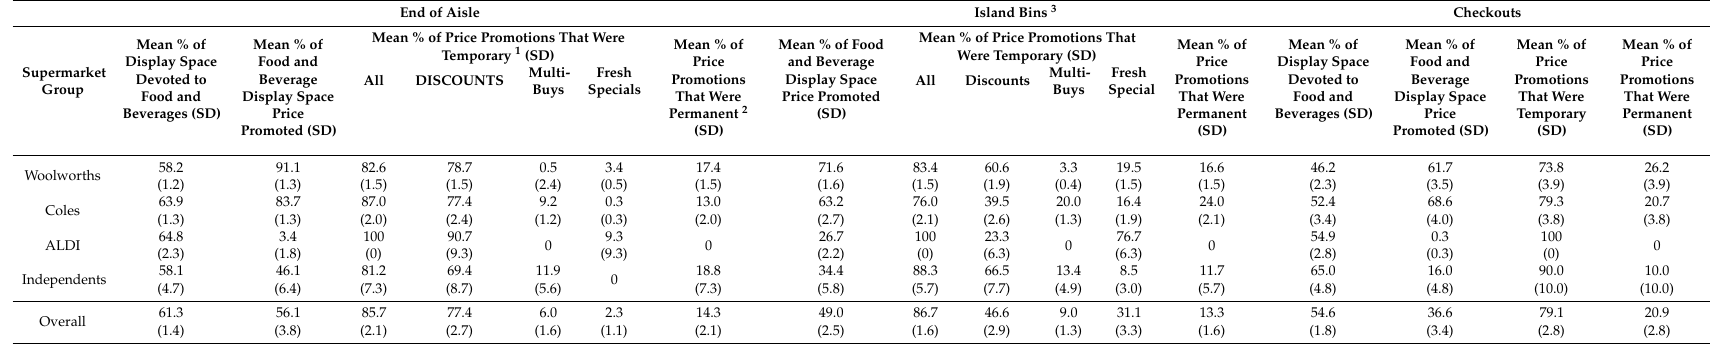
Table 1. Characteristics of food and beverage price promotions at prominent in-store supermarket locations, by supermarket